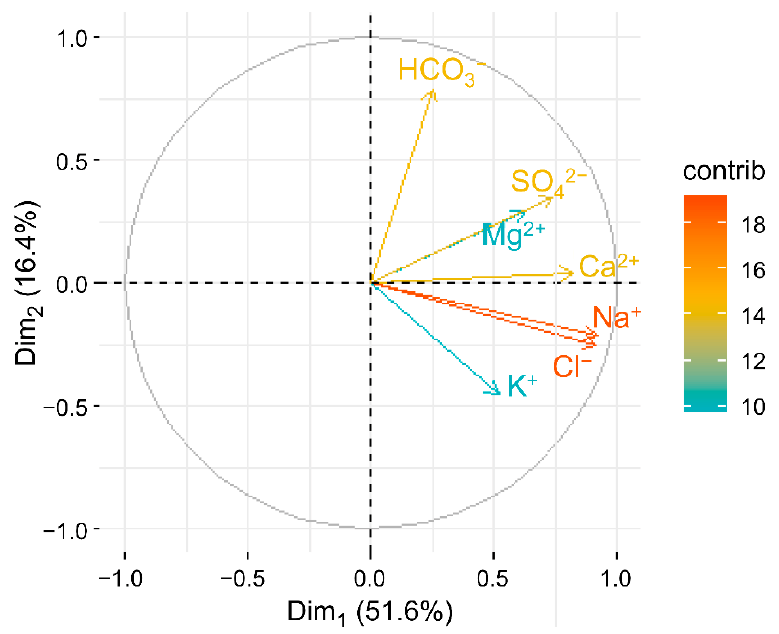
Figure 6. Distribution of the major ions in the first and second component space.